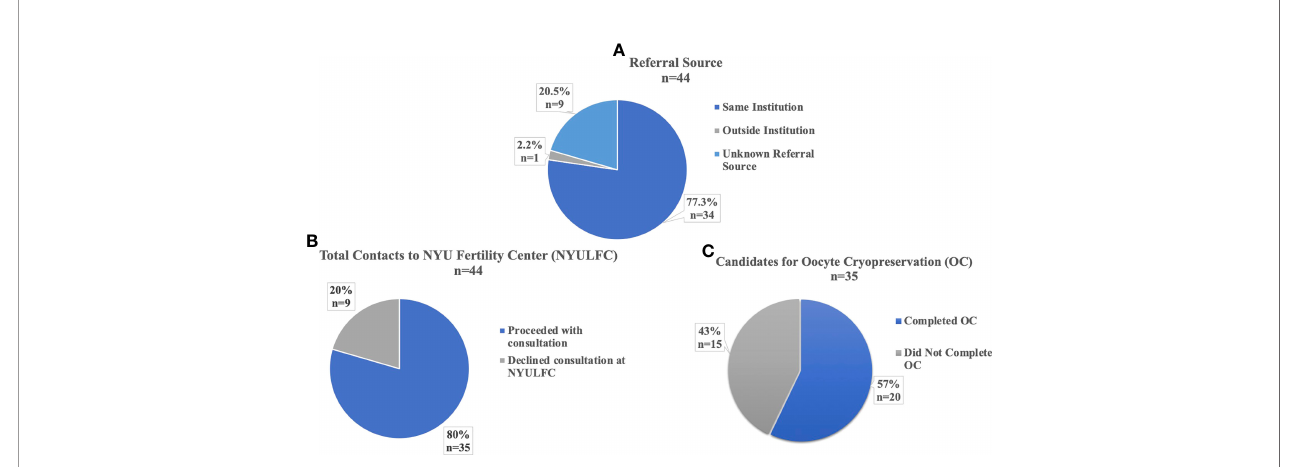
FIGURE 1 | Referrals and Utilization of AYA transmen at NYU Langone Fertility Center. (A) Institutional Source for Referral to NYU Fertility Center. (B) Percent of Total Contacts to NYU Fertility Center who Proceeded with Consultation. (C) Percent of Consultations who were Candidates for Oocyte